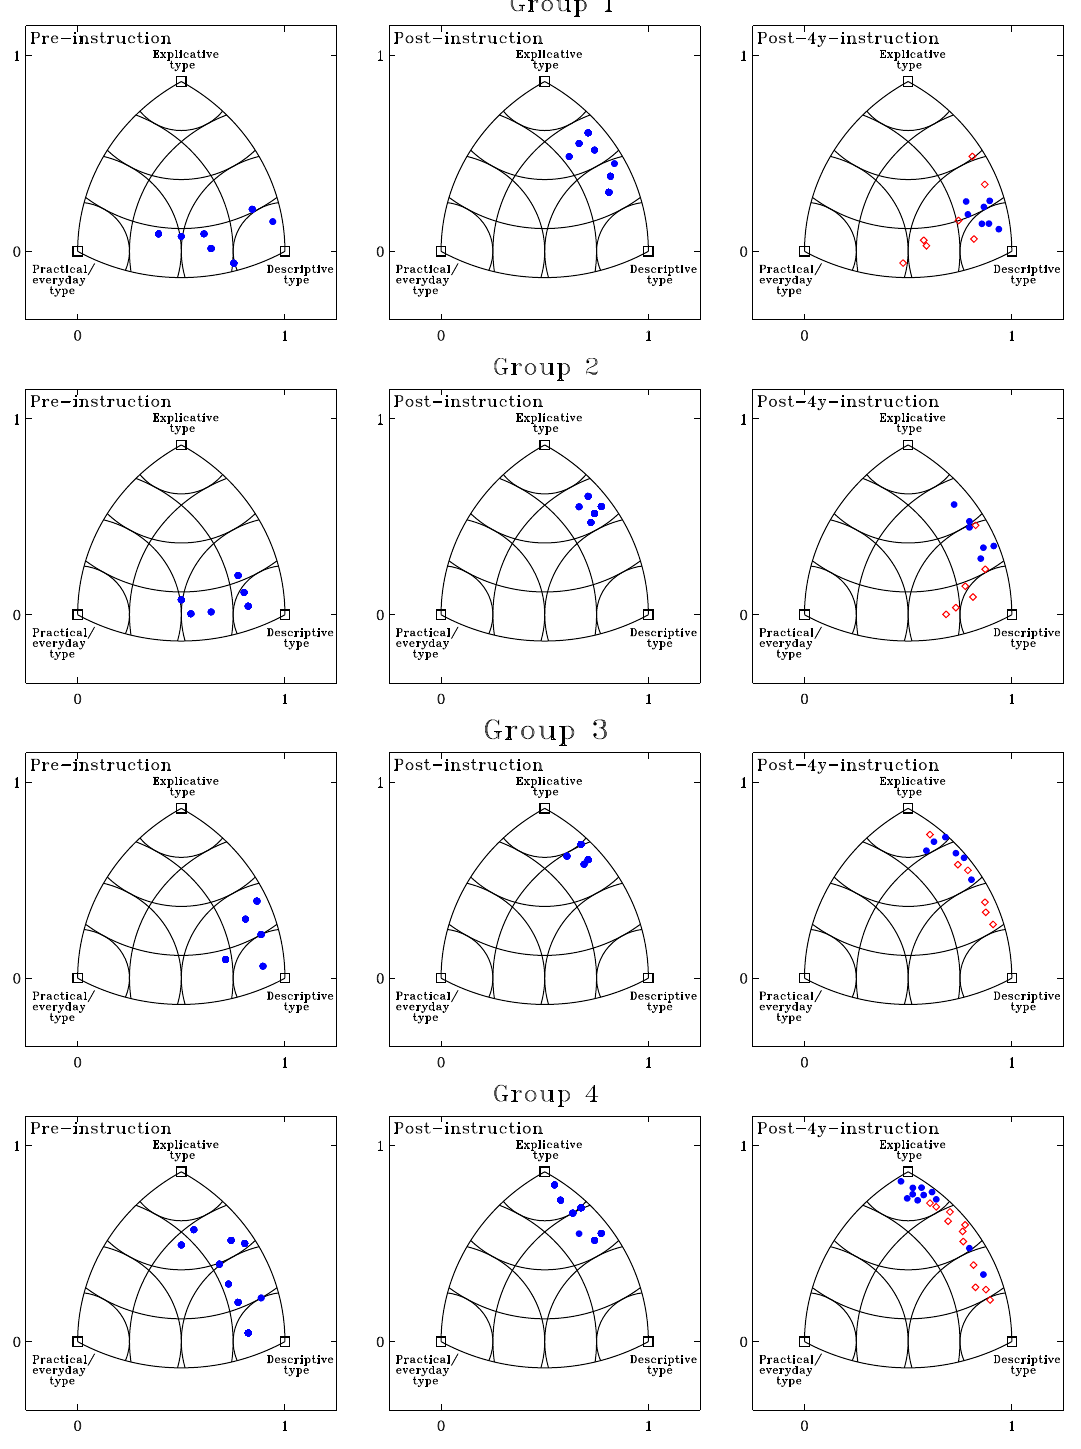
FIG. 5. Similarity graph for preinstruction (left column), postinstruction (central column), and post-4y-instruction (right column) data. The squares at the vertexes of an equilateral triangle represent the practical or everyday, descriptive and explicative typologies. The concentric circumferences mark the distances 0.25, 0.5, 0.75, and 1 from the vertexes. Blue circles represent the students belonging to the research sample, while red diamonds those belonging to the control